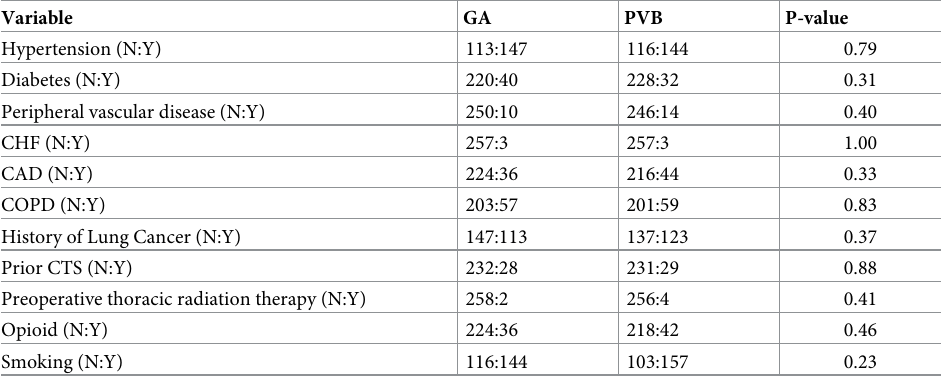
Table 2. Other covariates included for propensity score matching and their distribution in the study cohorts. Variable